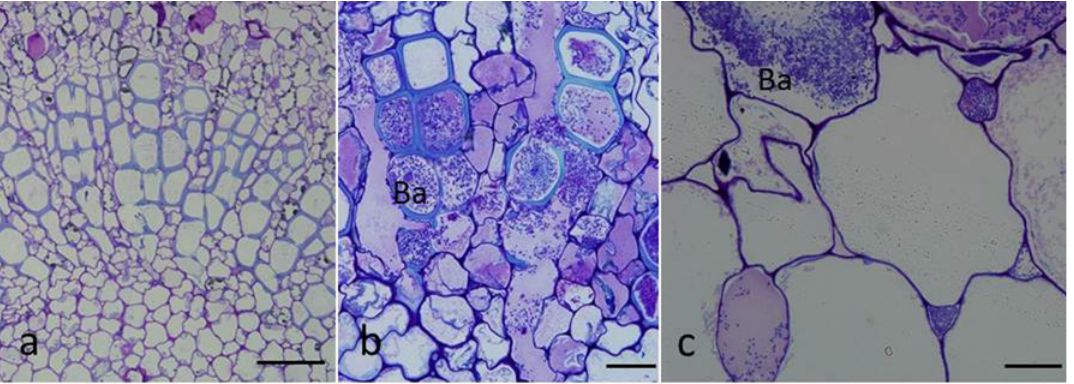
Fig 7. Light micrographs of leaf veins colonized by GFPuv-labeled Psa cells. (a), Cross-section of the healthy vein. Bar = 50 μ m; (b), bacterial colonization of vessels in the vascular bundle. Bar = 20 μ m; c, bacterial colonization of the cortex cells and intercellular spaces. Bar = 20 μ m.